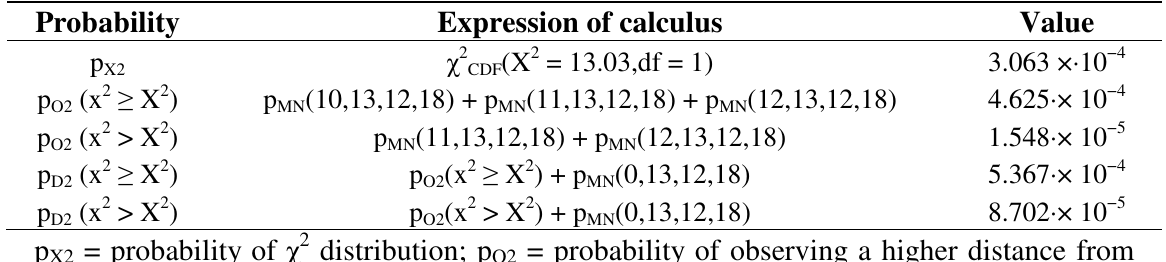
Table 10. Probability of